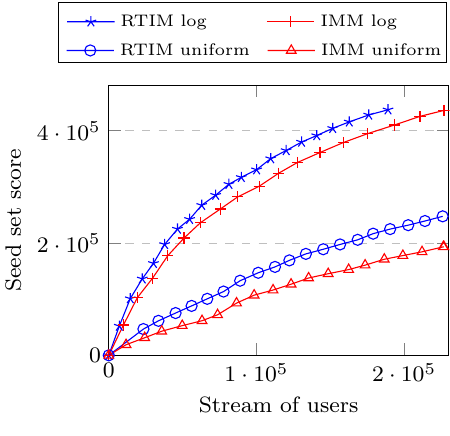
Fig. 5 Seed set score evolution with